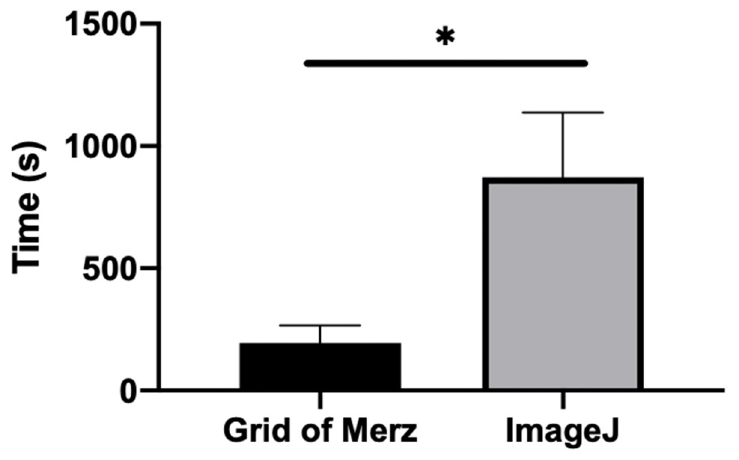
Figure 3. Graphic of the quantification analysis comparing the time (seconds) to quantify the histological samples using the grid of Merz and ImageJ. * p < 0.0001 .